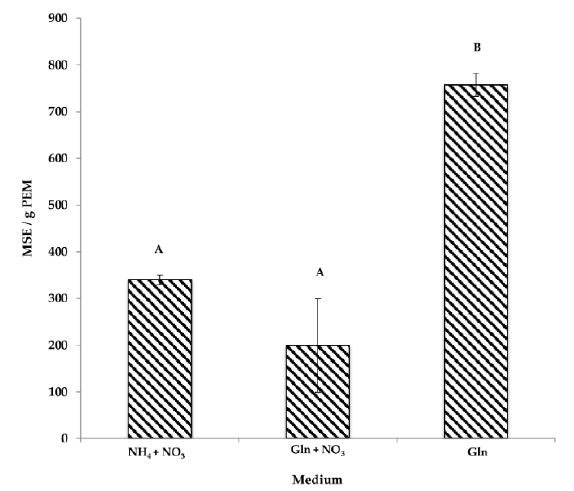
Figure 4. Average number of mature somatic embryos (MSE) developed per gram of PEMs on NH 4 + NO 3 medium, Gln + NO 3 medium and Gln medium after eight weeks with ABA. Different letters above the columns indicate significant differences based on the Tukey-Kramer HSD test, p ≤ 0.05.